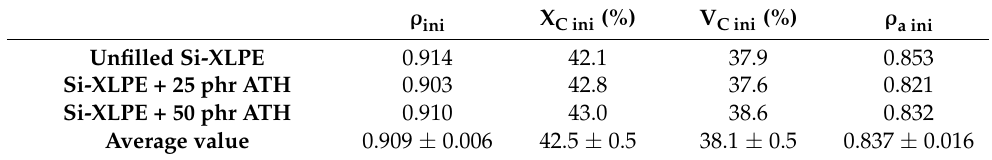
Table 4. Physical properties of the Si-XLPE matrix of the as-received materials, where ρ ini , X C ini , V C ini , and ρ a ini are its density, the mass and volume fractions of crystals, and the density of its amorphous phase, respectively. ρ ρ ini X C ini (%) V C ini (%) a ini Unfilled Si-XLPE 0.914 42.1 37.9 0.853 Si-XLPE + 25 phr ATH 0.903 42.8 37.6 0.821 Si-XLPE + 50 phr ATH 0.910 43.0 38.6 0.832 Average value 0.909 ± 0.006 42.5 ± 0.5 38.1 ± 0.5 0.837 ±